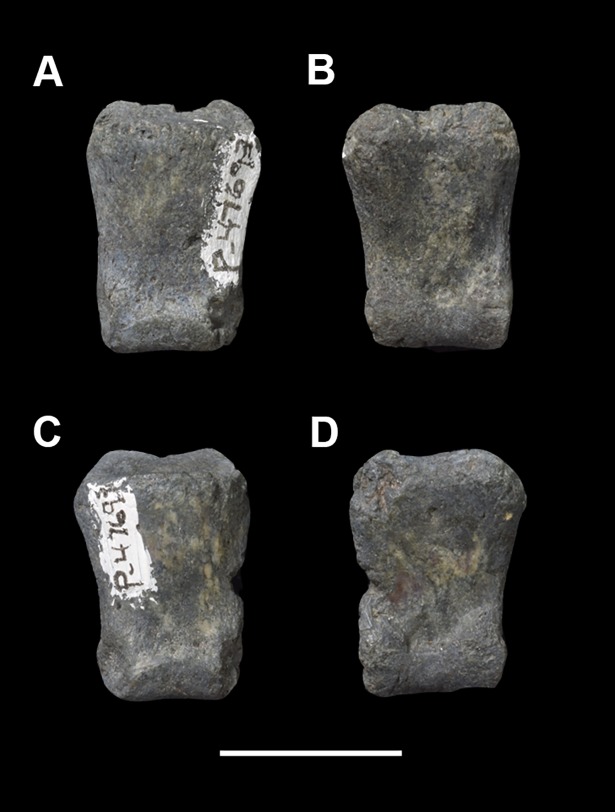
Two intermediate phalanges of Periptychus carinidens (NMMNH P-47693).A-B: third intermediate phalange in (A) dorsal view; (B) plantar view. C-D: second intermediate phalange in (C) dorsal view; (D) plantar view. Scale bar: 30mm.